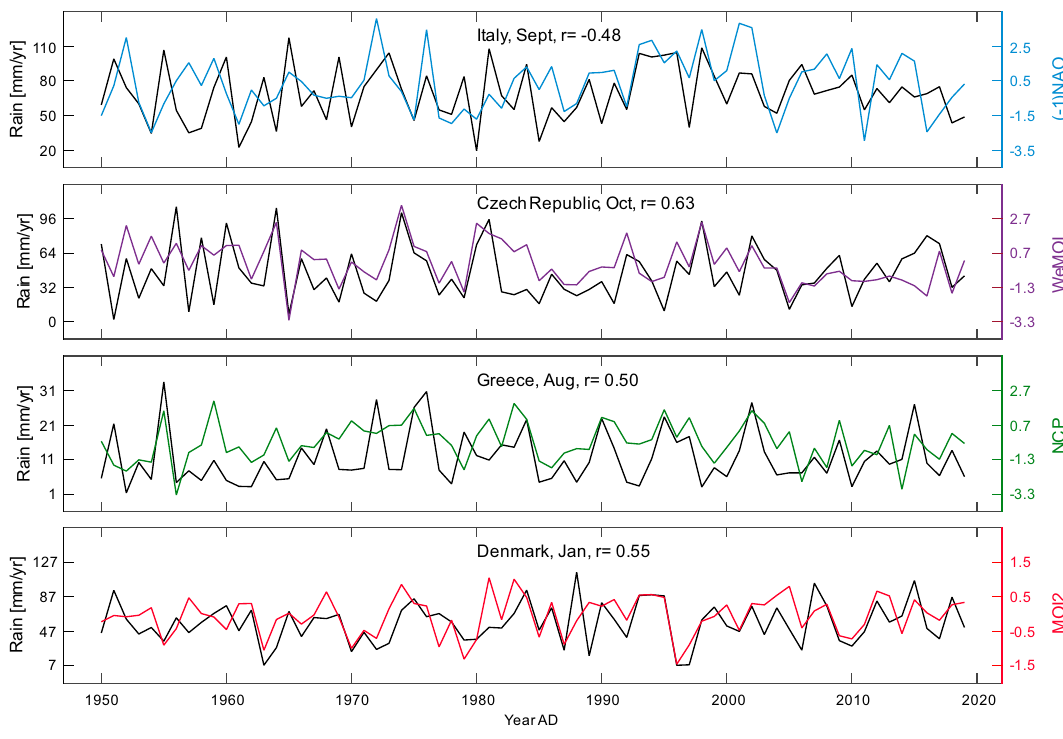
Figure 4. Illustration of four exemplary correlations r in a time series format: NAO and rain in Italy in September, WeMOI and rain in Czech in October, NCP and rain in Greece in August, and MOI2 and rain in Denmark in January. In the uppermost graph, the NAO series was mirrored at zero to facilitate comparison. More time series are provided in the Supplement (Fig. S6).